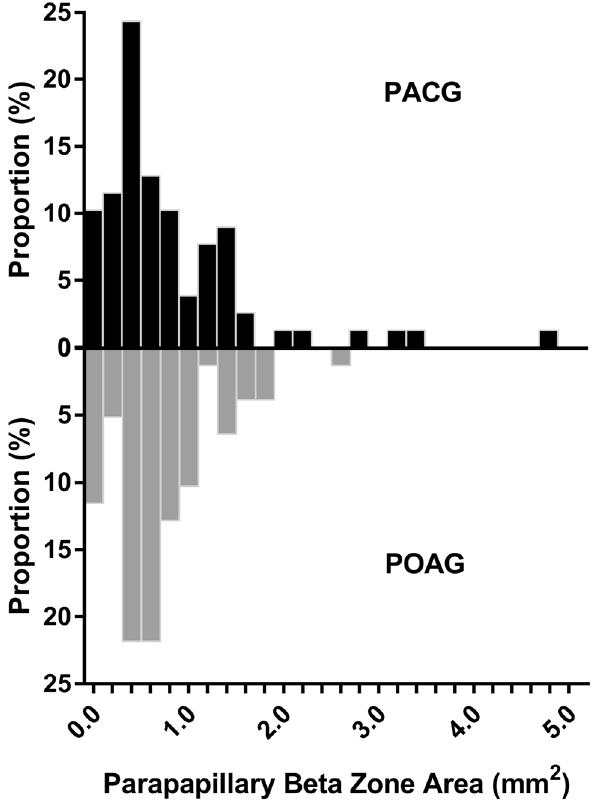
Figure 2. Distribution of the area of parapapillary beta zone in the POAG and PACG groups.